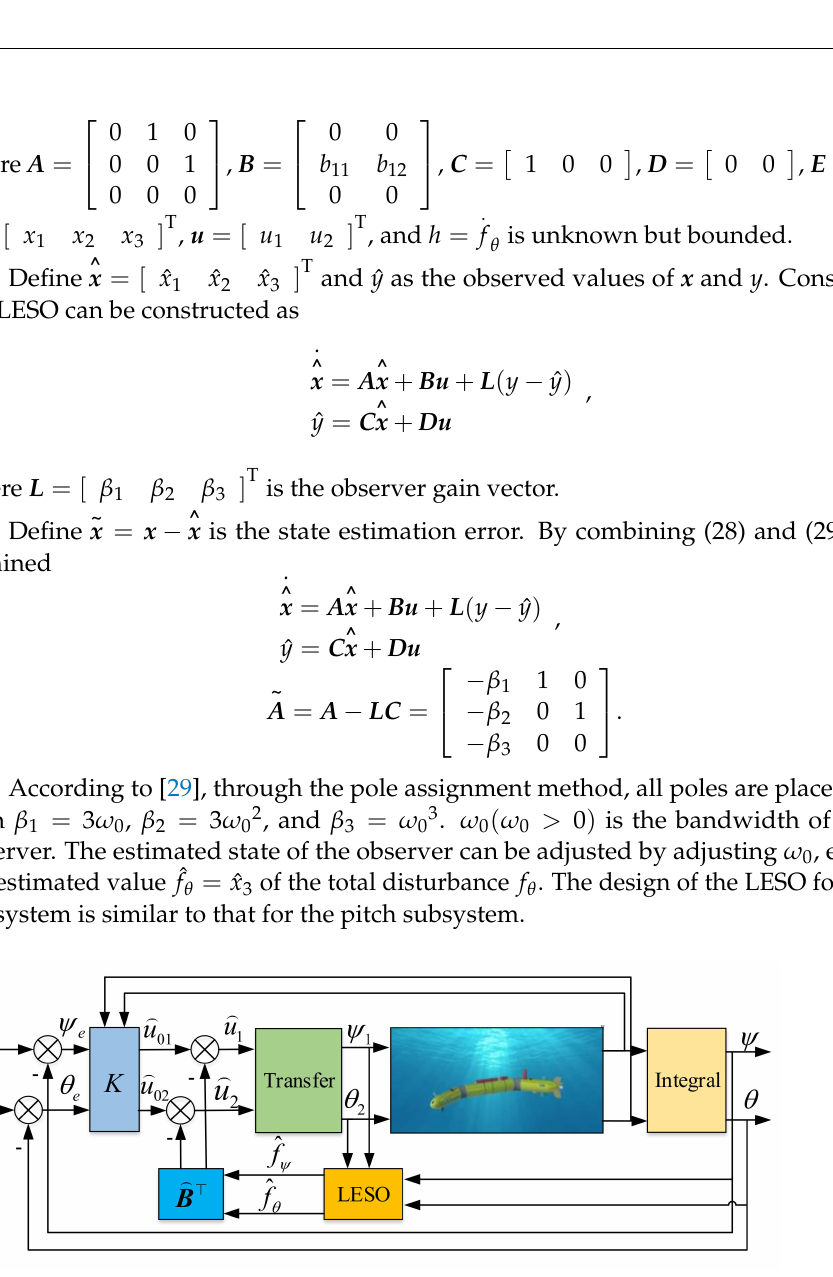
Figure 4. The structure of the LQR decoupling control method based on